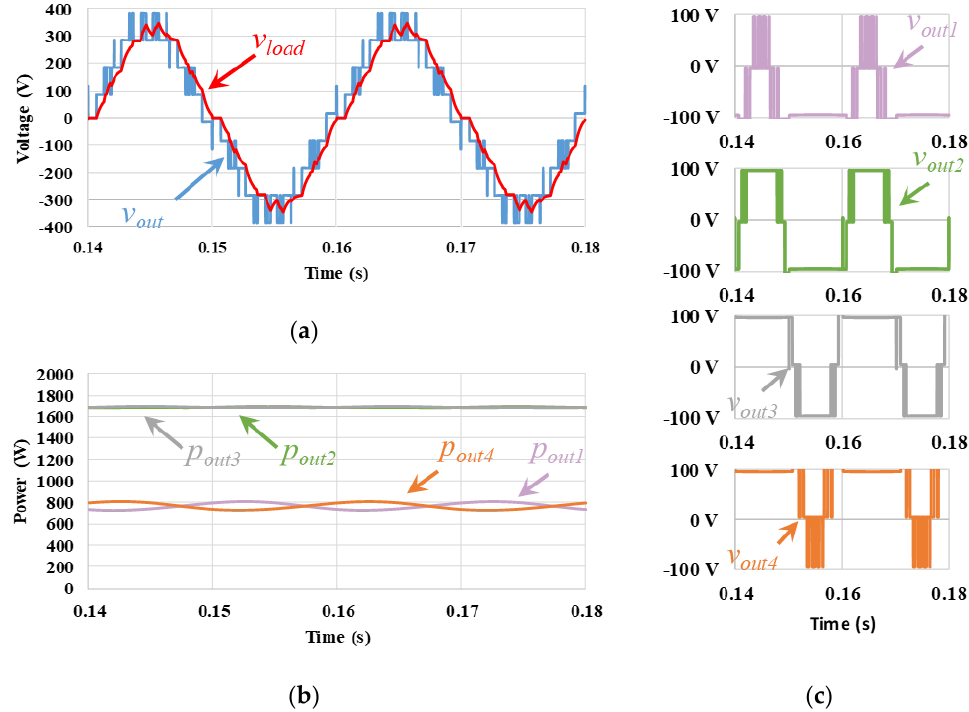
Figure 26. Simulation results of the CO-APOD PWM technique: ( a ) output voltage of the cascaded MLC, v out , and load voltage, v load ; ( b ) output power on each submodule ( p out1 , p out2 , p out3 , p out4 ); ( c ) output voltage on each submodule ( v out1 , v out2 , v out3 , v out4 ).